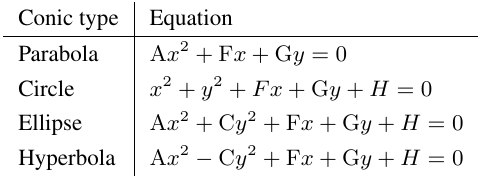
Table 1. Summary of general equations of